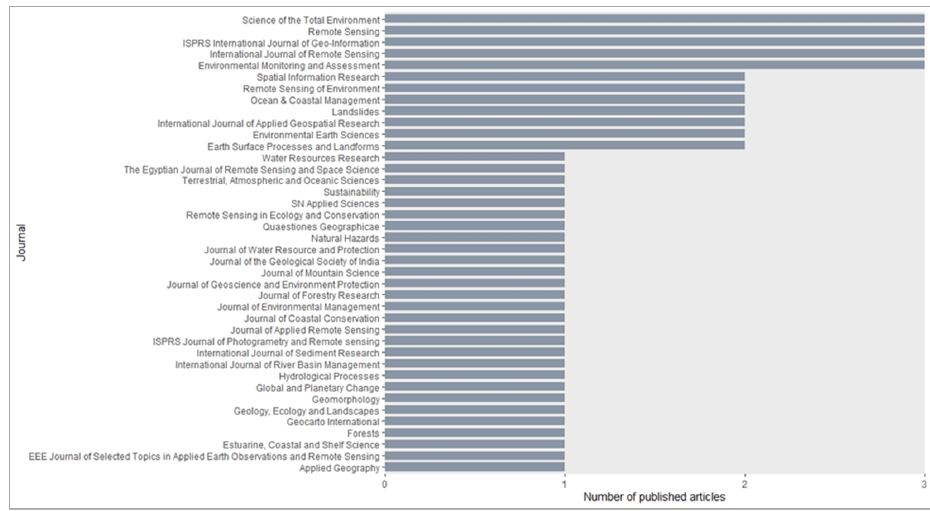
Figure 4. Number of articles on SDG 15 components using remote sensing published each year.